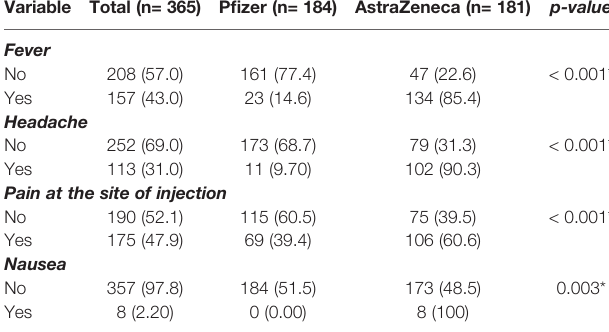
TABLE 1 | Sociodemographic and health characteristics of participants (n = 365).